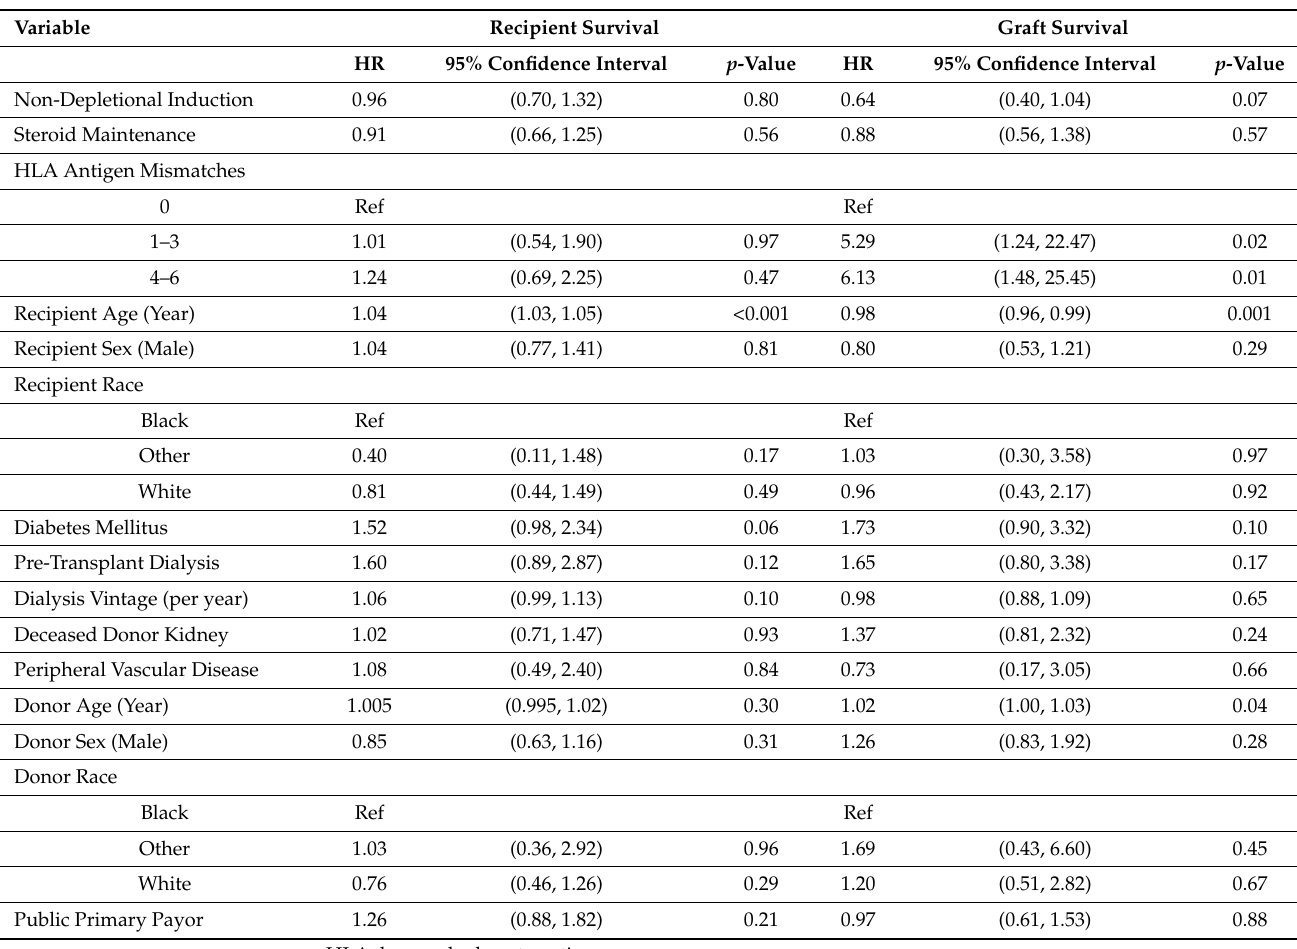
Table 5. Multivariable Cox Proportional Hazards Models for Recipient Survival and Death-Censored Graft Survival in